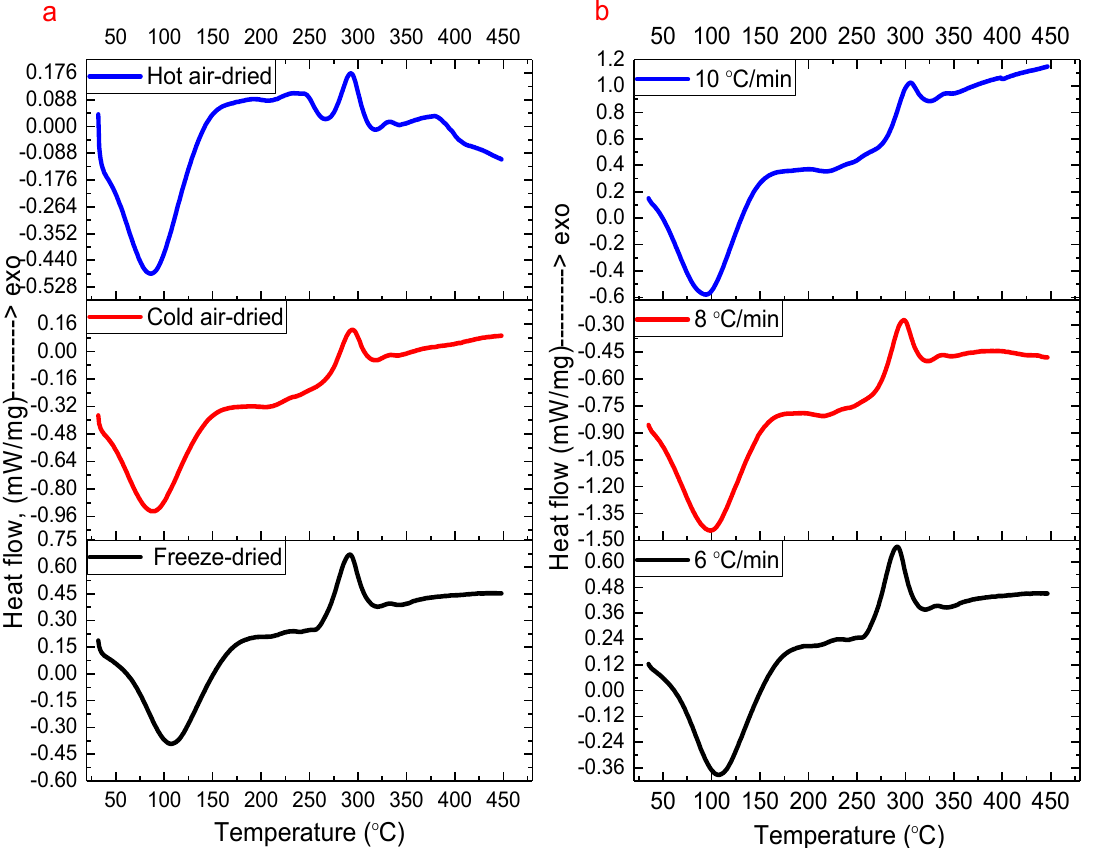
Figure 2. Di ff erential scanning calorimetry (DSC) thermal curves for ( a ) the T. fuciformis polysaccharides Figure 2. Differential scanning calorimetry (DSC) thermal curves for ( a ) the T. fuciformis dried by various processes at the selected scanning rate of 6 ◦ C / min and ( b ) freeze-drying with the polysaccharides dried by various processes at the selected scanning rate of 6 °C/min and ( b ) freeze- multiple scanning rates of 6, 8, and 10 ◦ C / drying with the multiple scanning rates of 6, 8, and 10 °C/min.